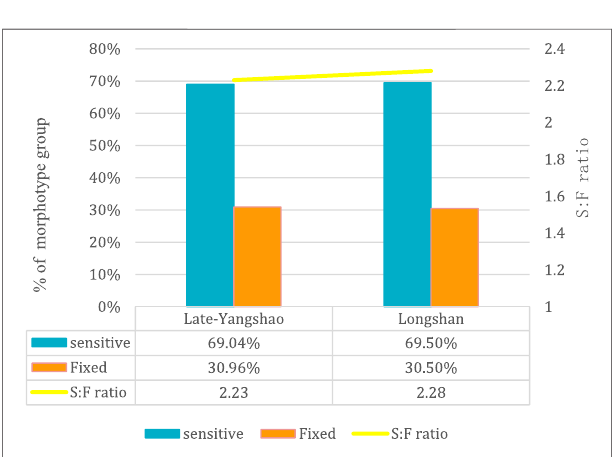
FIGURE 8 | Percentage of sensitive versus fi xed phytolith morphotypes in two periods at the Suyang site; percentages exclude all phytolith types not within the sensitive/ fi xed classi fi cation as de fi ned by Weisskopf et al. (2015a).